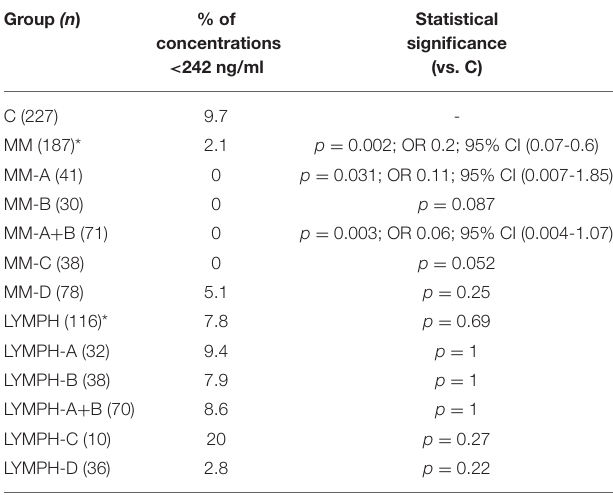
TABLE 7 | Frequency of low serum concentrations of collectin CL-LK in investigated groups (for MM and LYMPH groups: data from sample 1, taken before